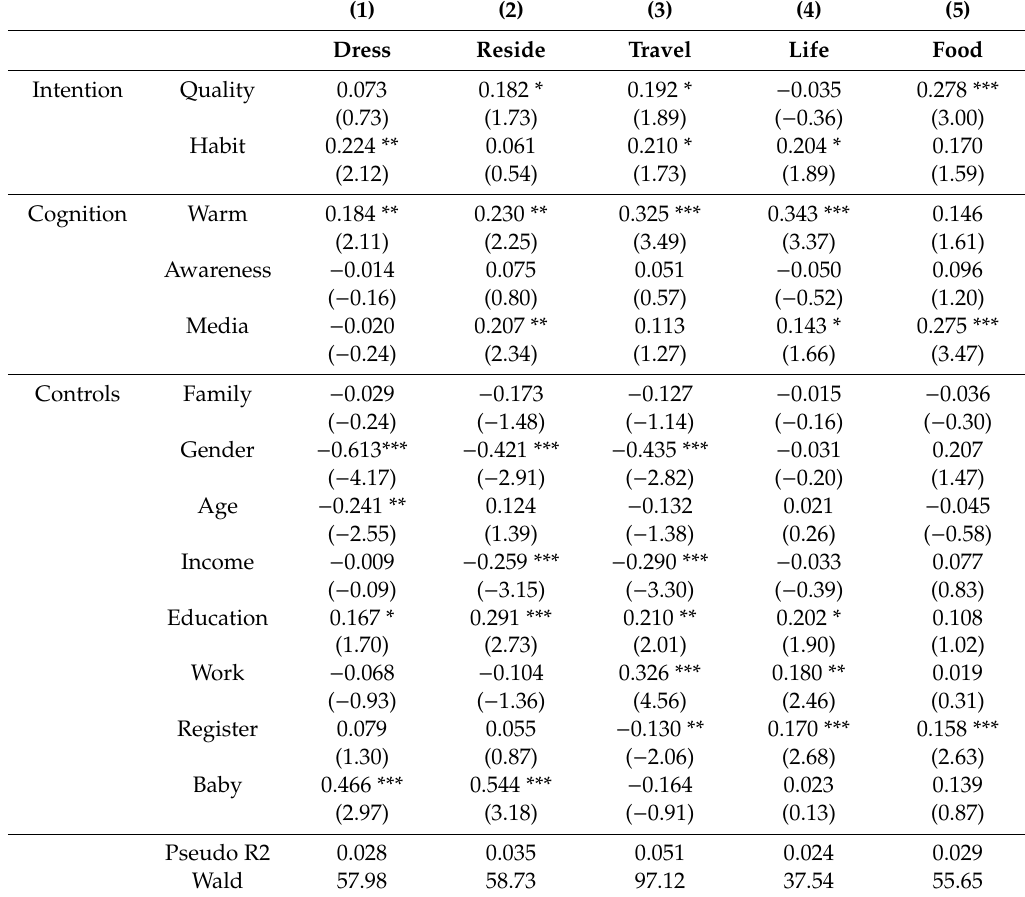
Table 5. Regression analysis on low-carbon behaviors at di ff erent